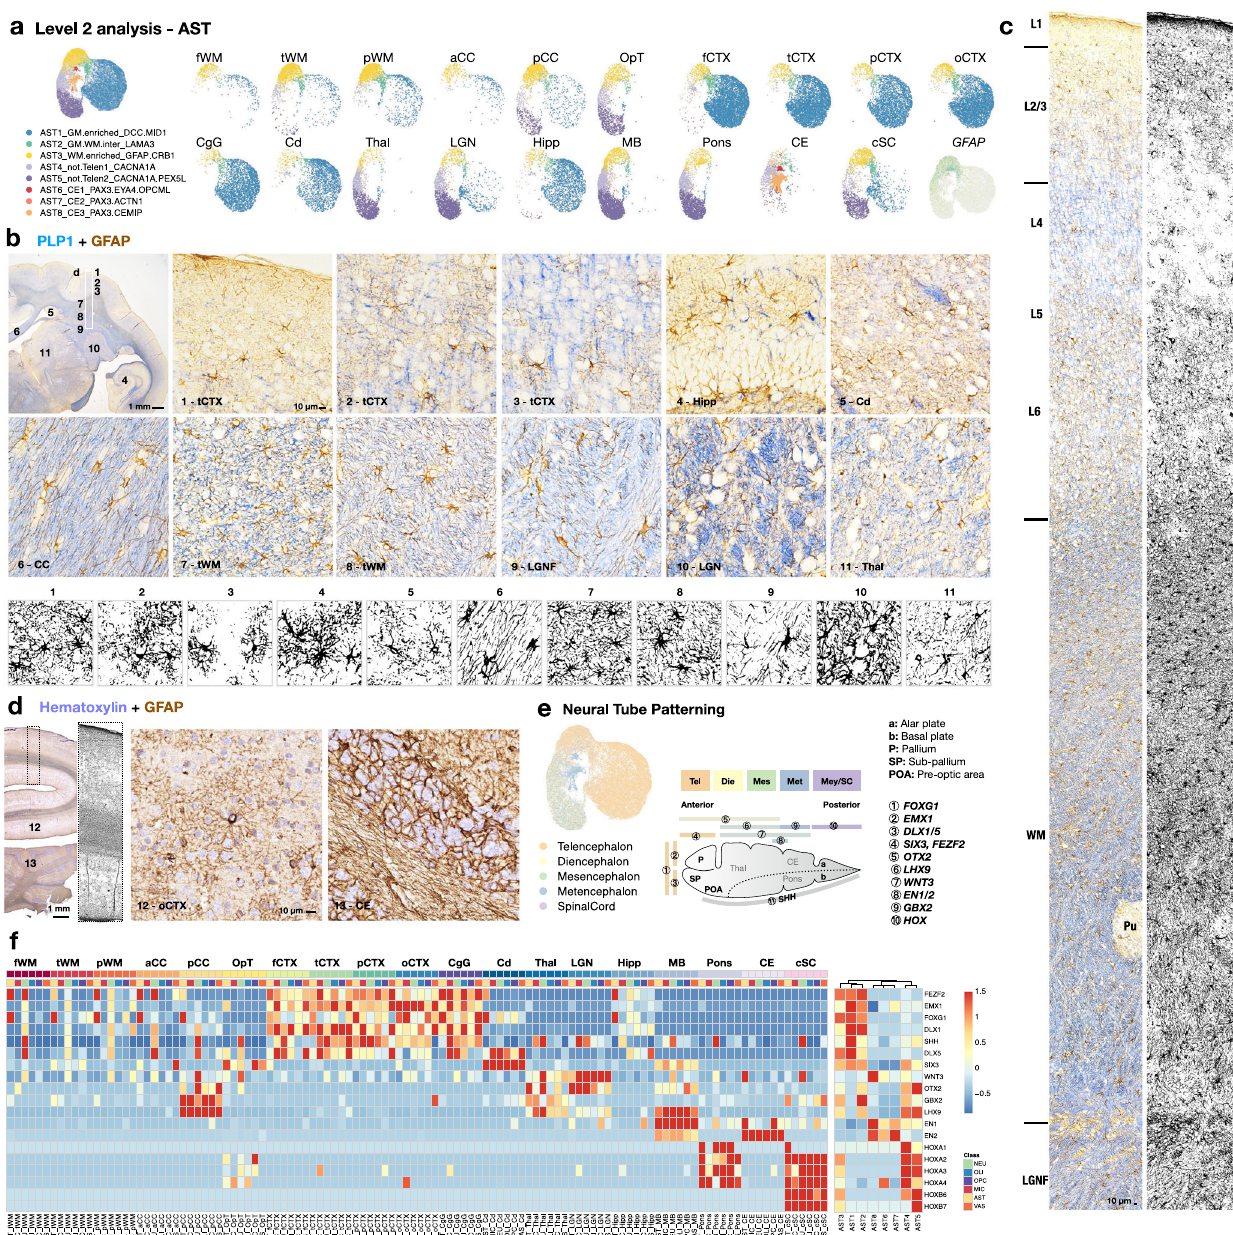
Fig. 6 | Neural tube boundary-restricted astrocytes persist into adulthood. a UMAPplot visualization of astrocytes (AST)coloredbyLevel2 subclustering and split by tissue type. b The expression of GFAP in a mid-coronal section of the marmosetbrain.IntensePLP1labelingdemarcatesthewhitematter.Enlargedareas are boxed and numbered on the 1x image (top left panel). The morphology of GFAP + cells across tissue types was extracted by image processing (Method). The experiment was repeated independently three times with similar results. c The distribution and morphology of GFAP + cells along layers of cortex and adjacent whitematter.Theexperimentwasrepeatedindependentlythreetimeswithsimilar results. d The expression of GFAP in the occipital lobe and cerebellum; nuclei are stainedwithhematoxylin.Enlargedareasareboxedandnumberedonthe1ximage.